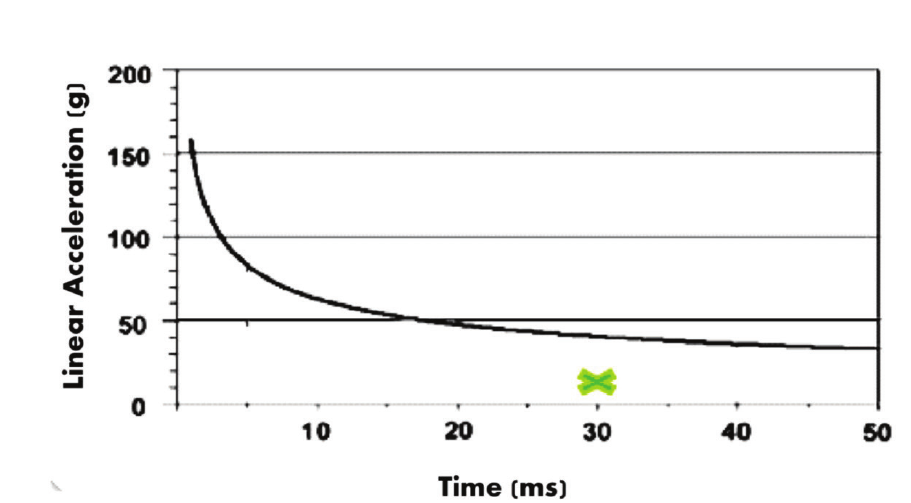
FIGURE 3. Comparison of Obtained Linear Acceleration with The Threshold Tolerance Curve of the head